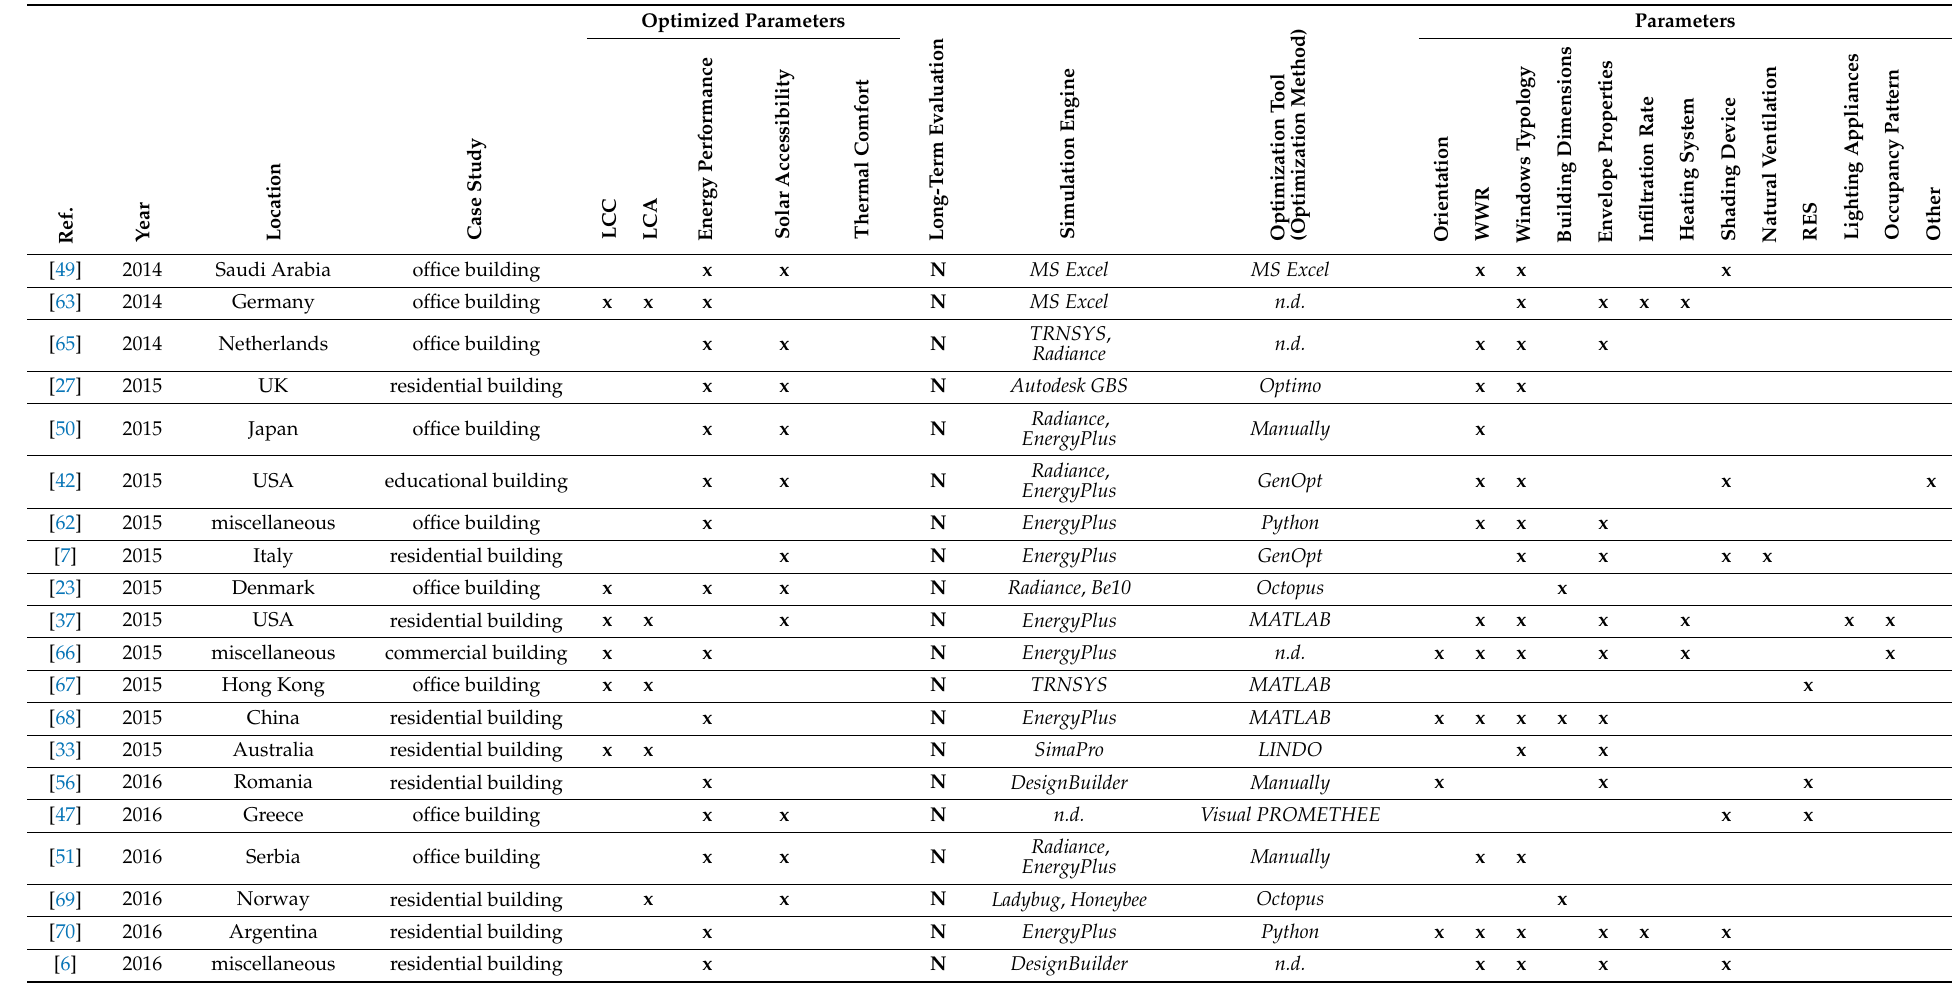
Table A1. Tabular review of the selected journal